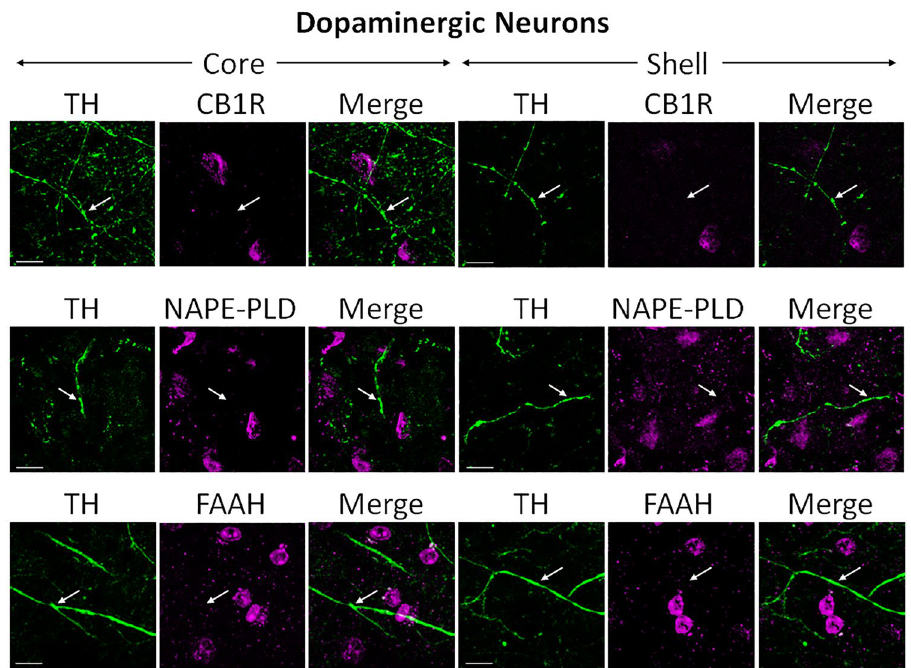
Figure 6. Double-label immunofluorescence illustrating co-localization of CB1R-IR, NAPE-PLD-IR, and FAAH-IR with tyrosine hydroxylase (TH). Confocal micrographs of NAc co-immunolabeled for CB1R, NAPE- PLD, or FAAH (magenta), and TH (green), a specific marker for dopaminergic projections, in core and shell. Arrows point at TH-positive axons and terminals that do not express either CB1R, NAPE-PLD, or FAAH. Scale bar = 10 µ